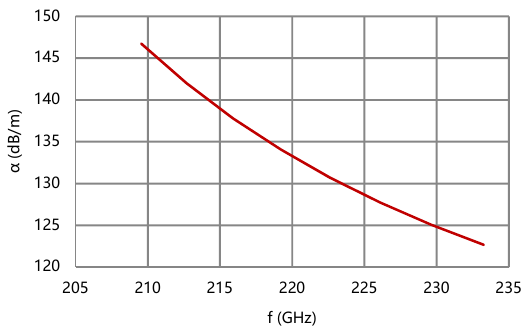
Figure 9. Attenuation coefficient of the folded waveguide circuit.